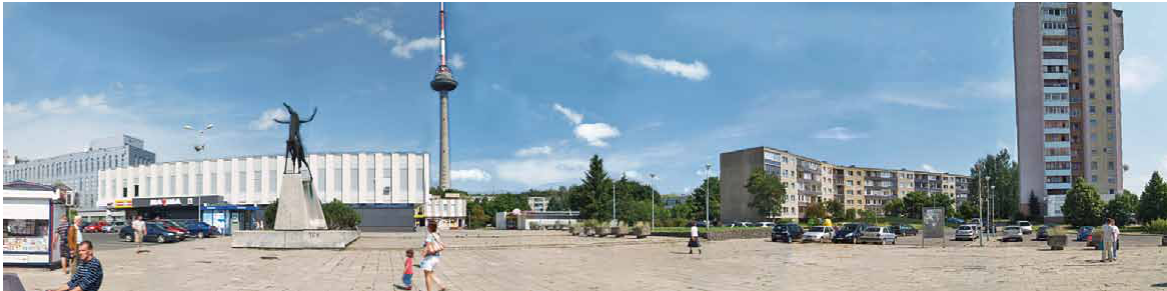
Fig. 6. Panoramic views of main Public Spaces in Žirmūnai and lazdynai residential